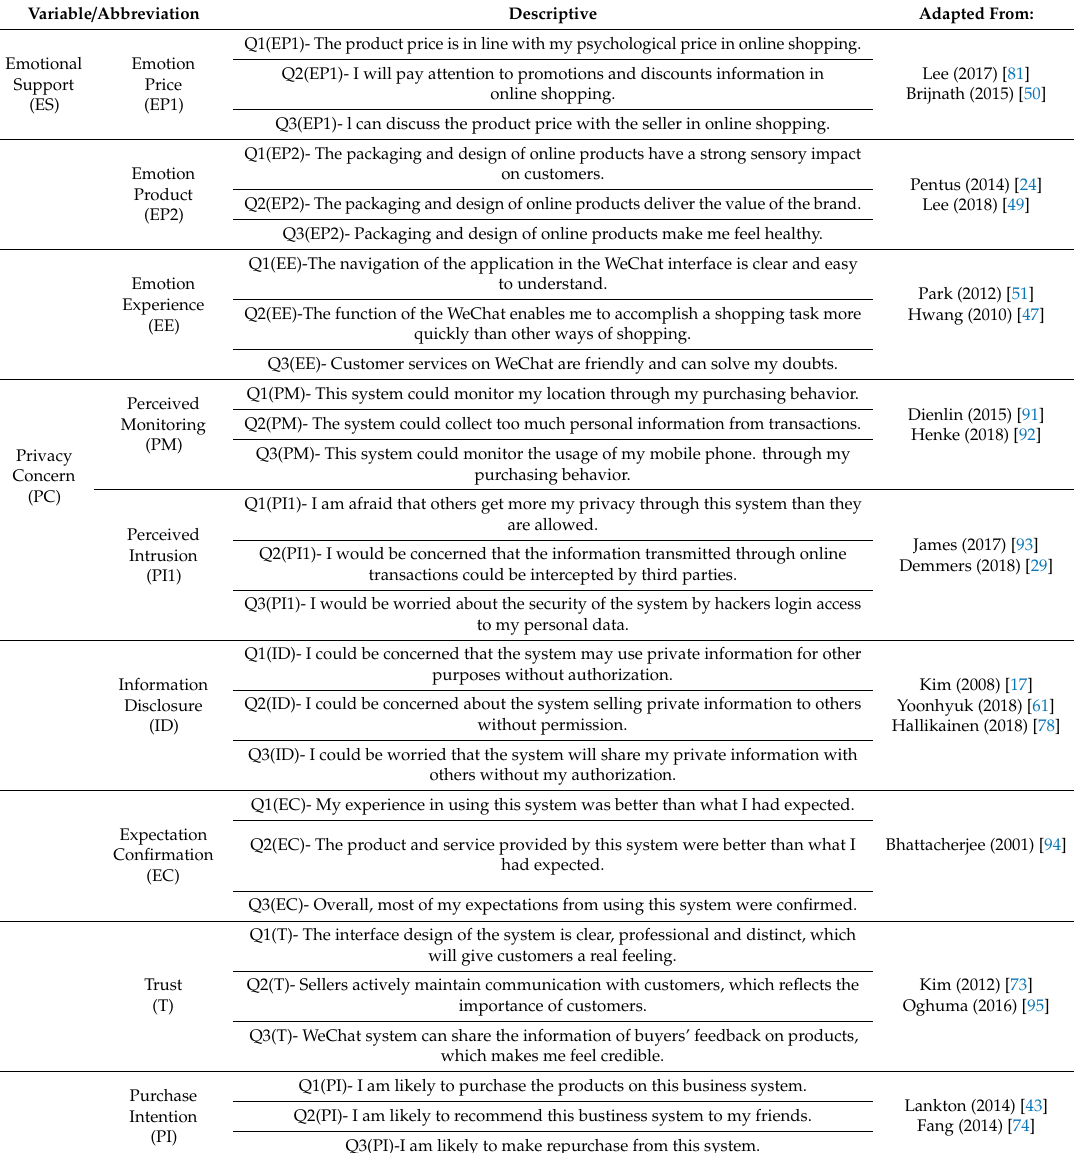
Table 1. Summary of specific measurement questions of questionnaire